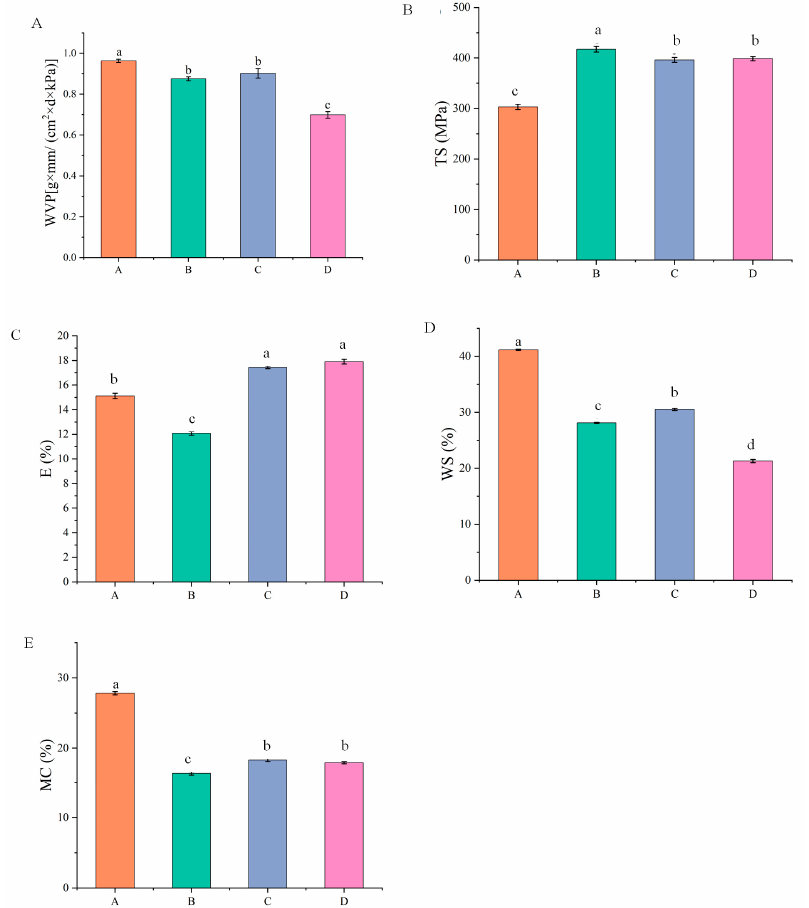
Figure 2. ( A ) Effect of each component on water vapor transmittance of composite film; ( B ) Effect of each component on tensile strength; ( C ) Effect of each component on elongation at break; ( D ) Effect of components on water solubility of composite film; ( E ) Effect of components on water content of composite film (A: pure SA membrane; B: SA/CW composite membrane; C: SA/CW/G composite membrane; D: SA/CW/G/Vc-Ca composite membrane).